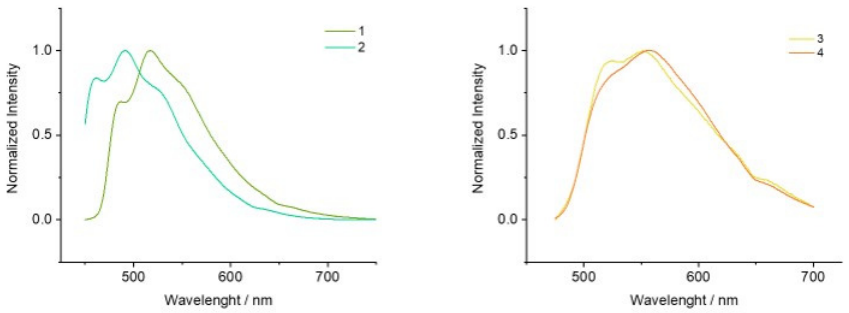
Figure 3. Emission spectra of complexes 1 – 4 in DMSO solution at 298 K.